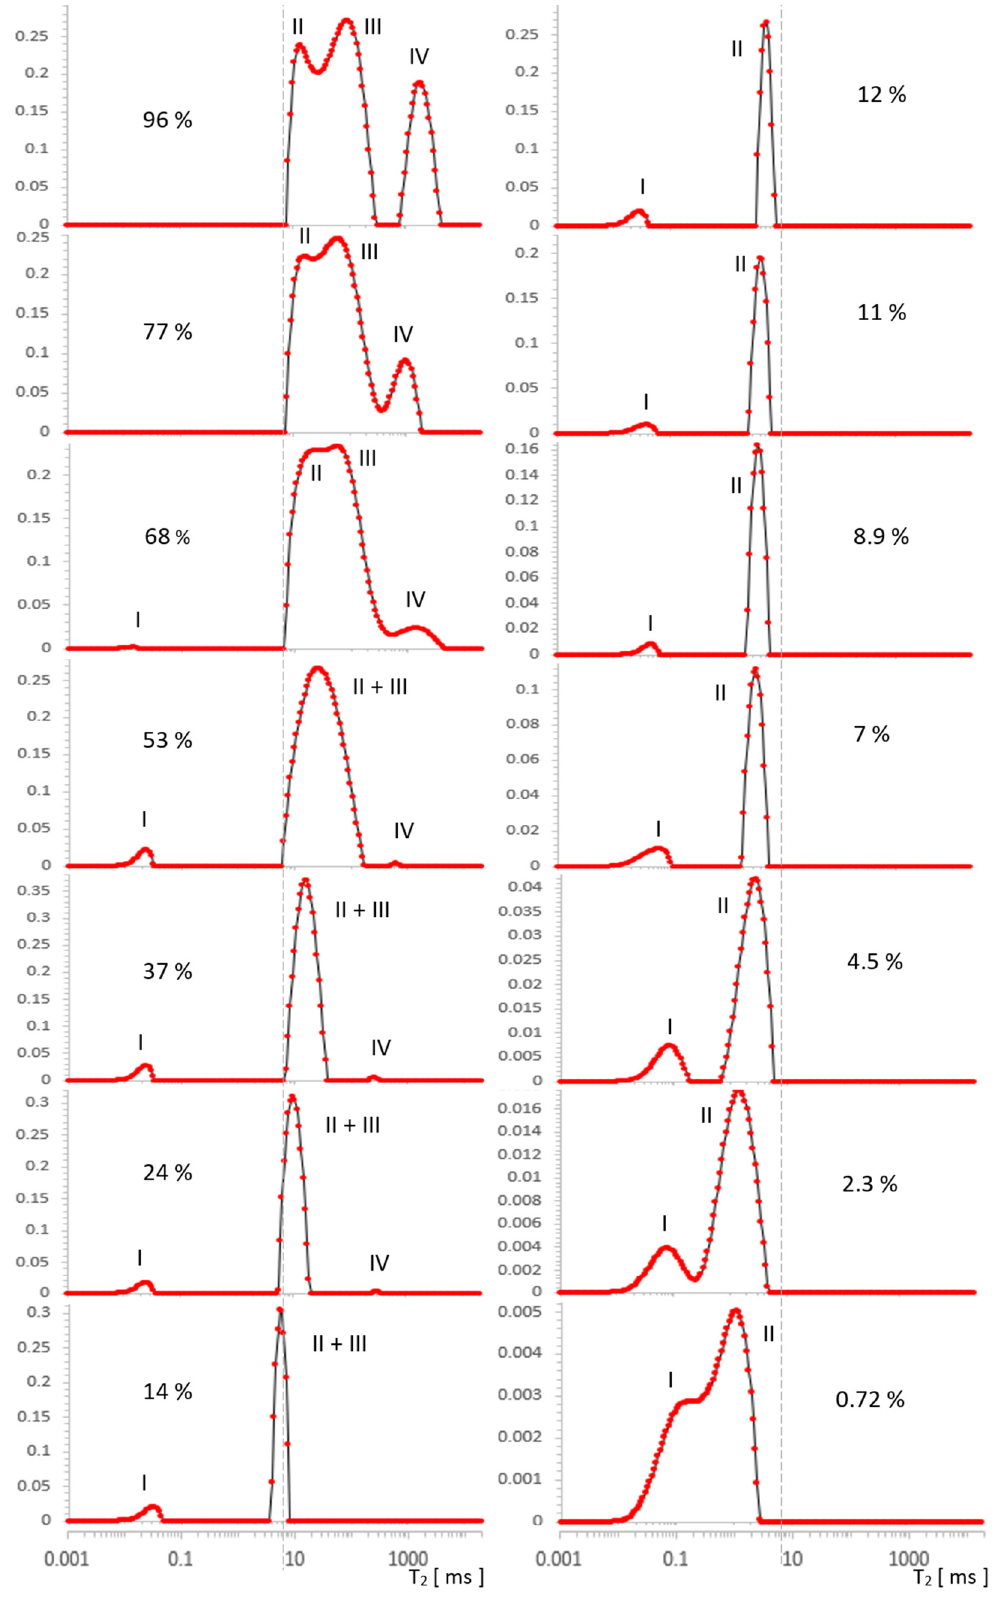
Figure 3. Evolution of T 2 spectrum for MCM-41, obtained in [a.u.] using ILT transform, along a series of water saturations. I—OH groups, II—intra pore water, III—inter pore water, IV—free water. The vertical axes represent the values of the ILT transform in [a.u.] units.